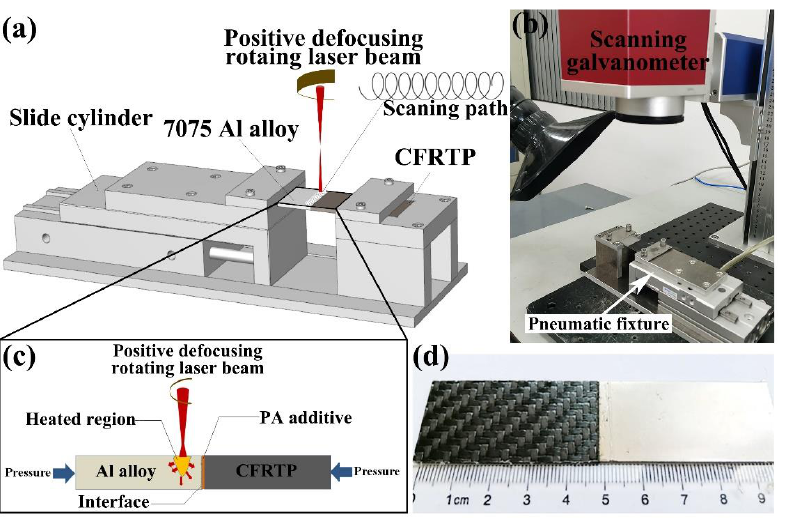
Figure 3. ( a ) Schematic of the laser joining Al/carbon fiber reinforced thermoplastic (CFRTP) butt joint, ( b ) the laser joining equipment and specimen fixture, ( c ) the schematic Al/CFRTP butt joint and its laser joining, and ( d ) the image of laser joined Al/CFRTP butt joint.